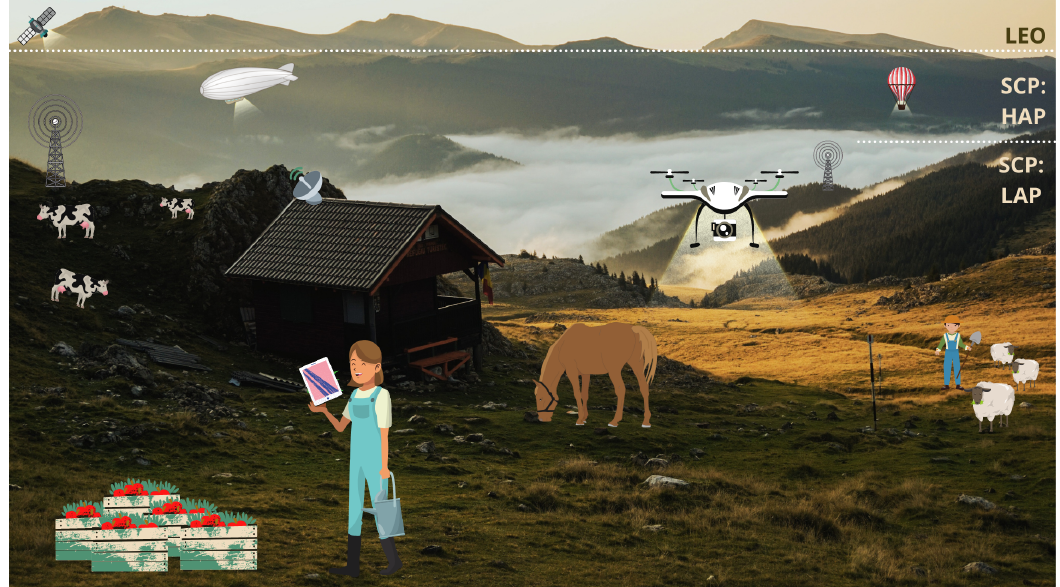
Figure 3. Some solutions for outdoor networks